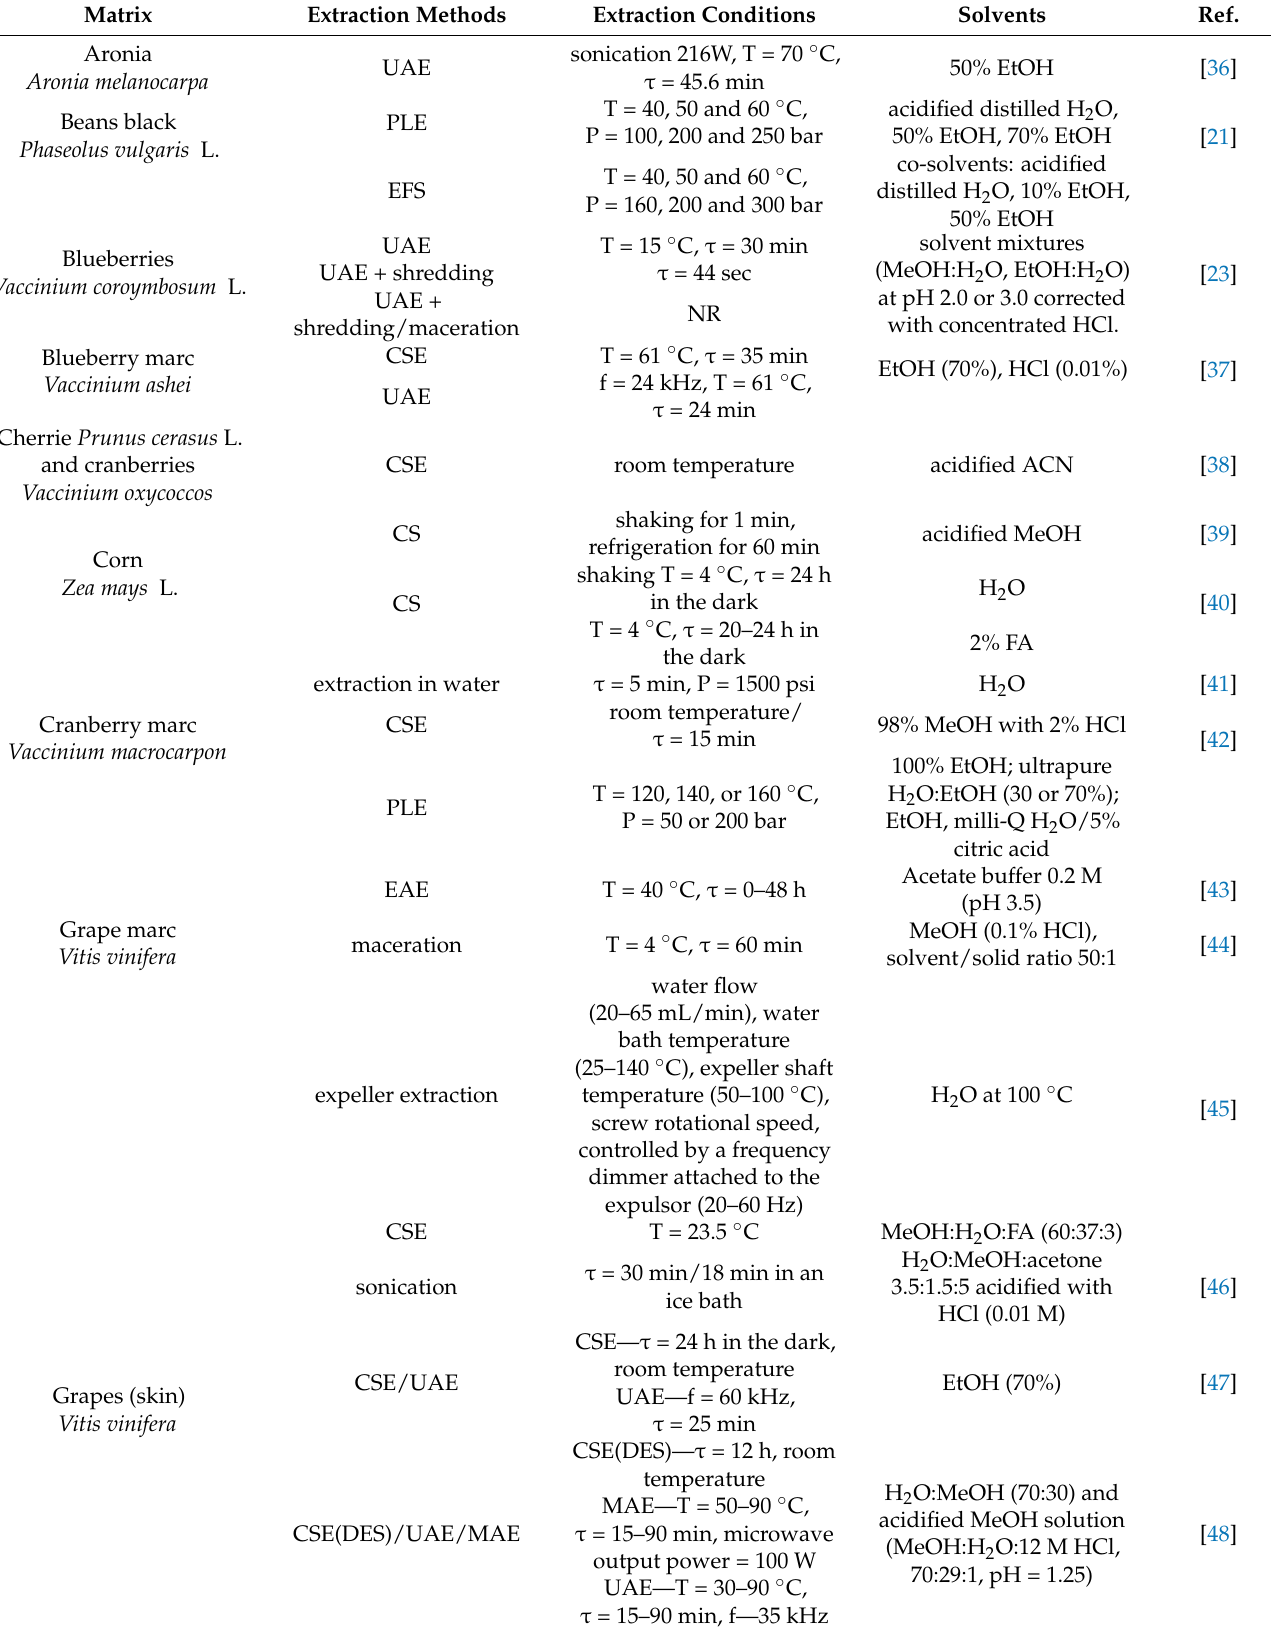
Table 2. Extraction procedures applied for the recovery of anthocyanins from different food